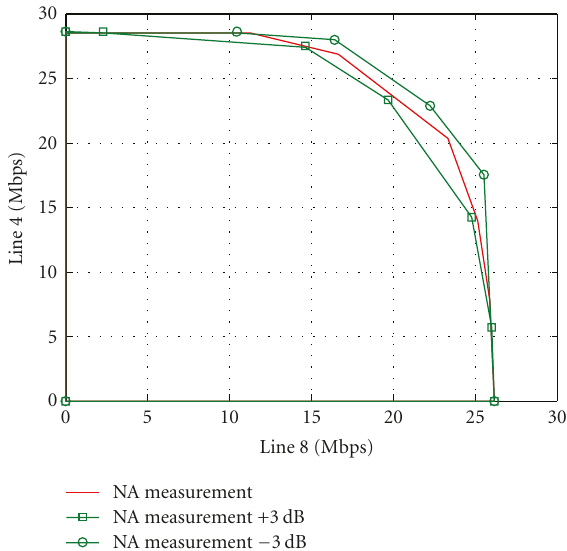
Figure 9: Simulation results obtained with the ISB algorithm.